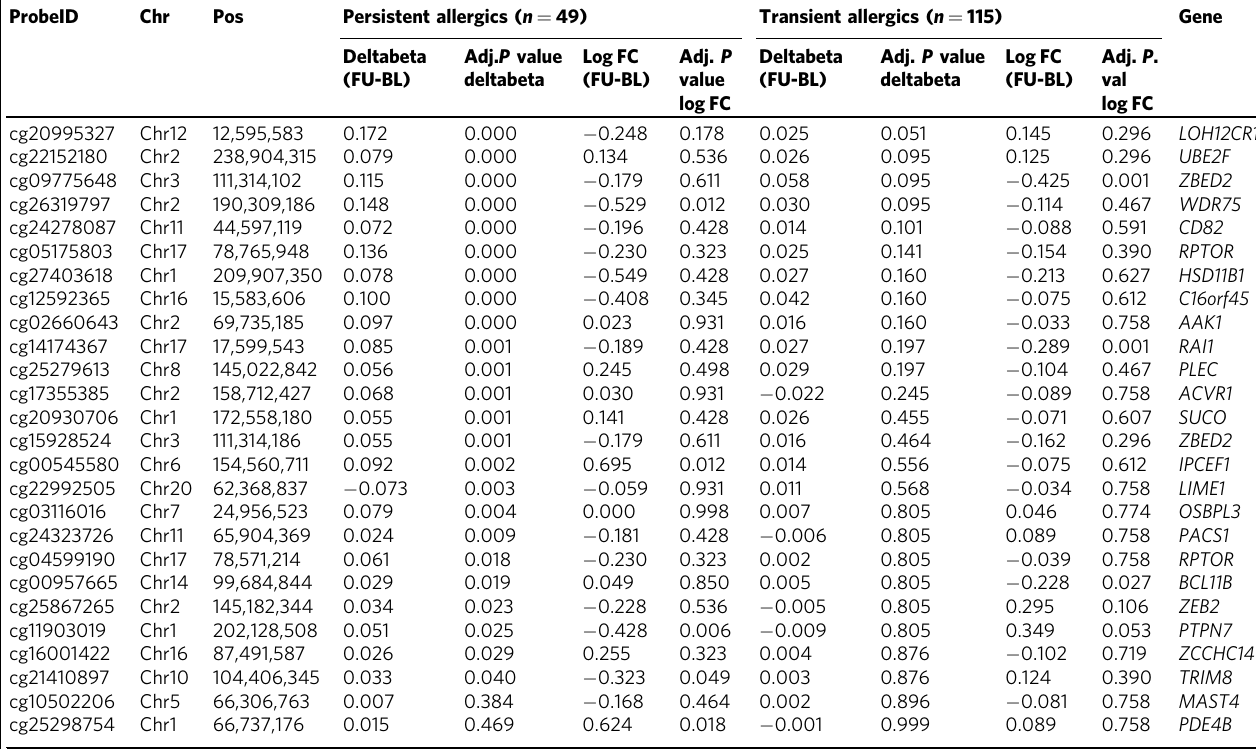
Table 4 Longitudinal analysis of differentially remodeled genes